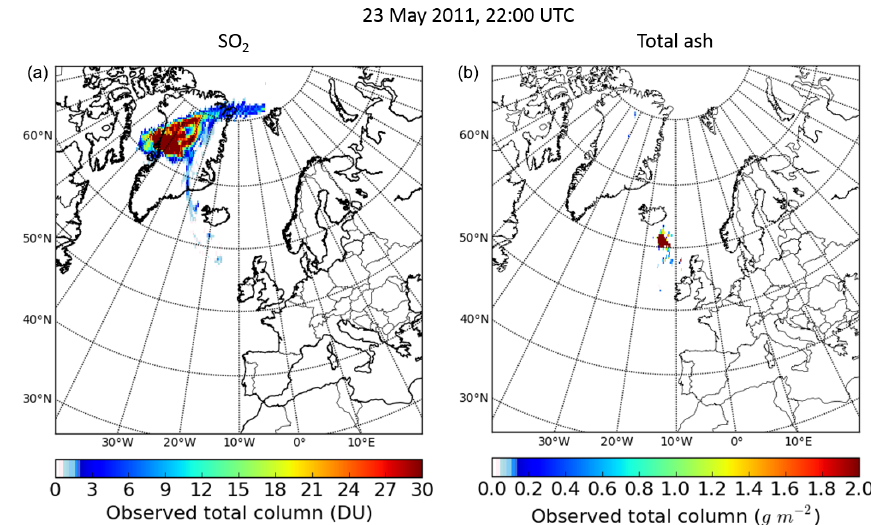
Figure 1. IASI SO 2 (a) and total ash (b) observations on 23 May 2011,